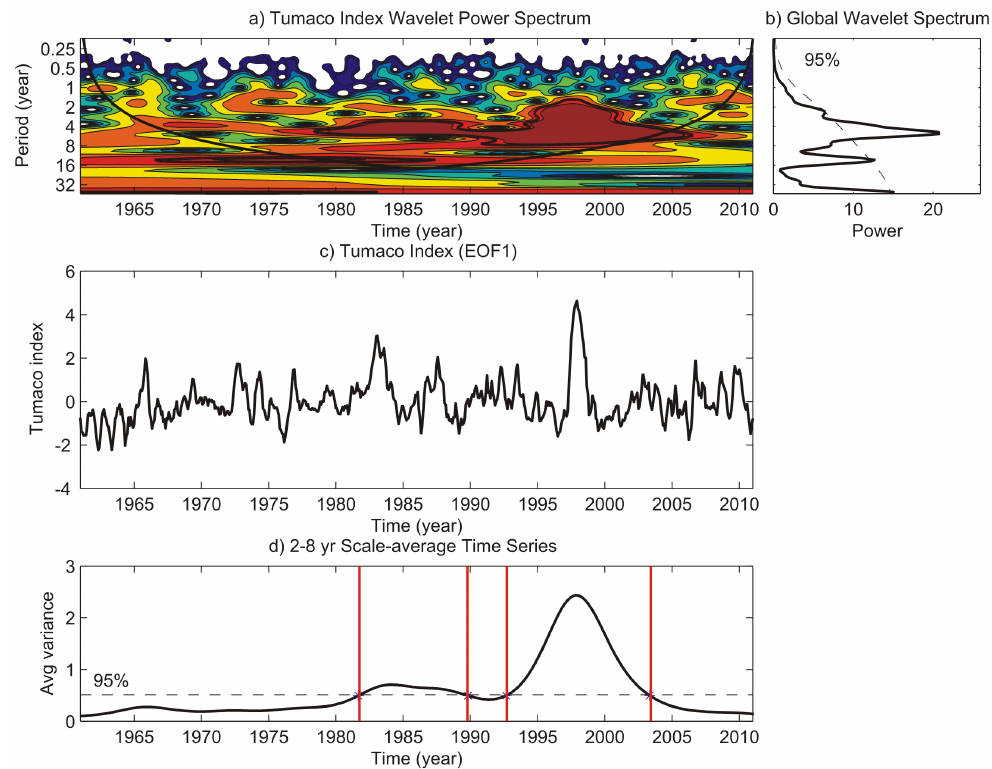
Fig. 3. Morlet wavelet power spectrum of EOF1 (a) , global wavelet spectrum (b) , time series of EOF1 (c) and 2–8yr scale-averaged power wavelet of the EOF1 time series of Tumaco sea–air variables (d)